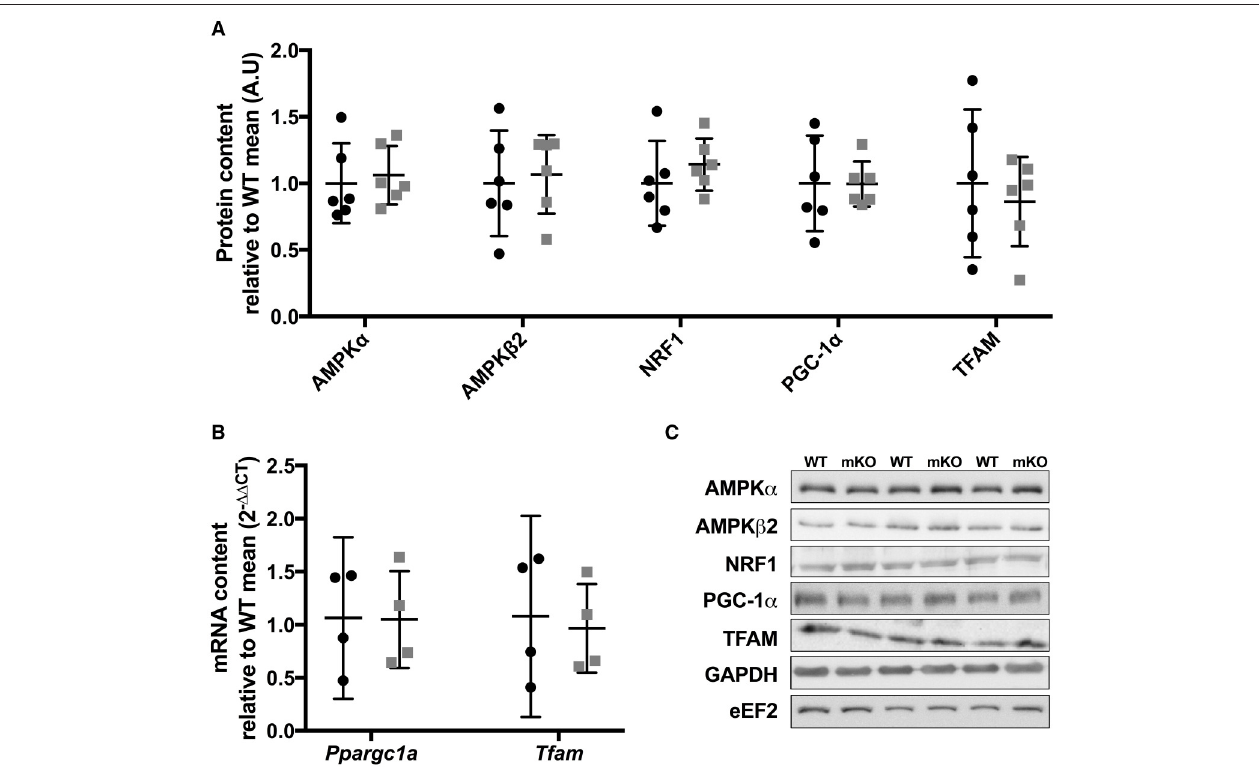
FIGURE 5 | Protein content of mitochondrial biogenic signalling and transcriptional proteins in p53 mKO (grey squares) and WT (black circles) mice. (A) The content of proteins regulating energy sensing (AMPK α , AMPK β 2), nuclear transcription (NRF1 and PGC-1 α ) and mitochondrial transcription (TFAM) are comparable in gastrocnemius muscle of WT (black circles) and p53 mKO (grey squares) mice ( p > 0.05; n = 6 per group). Similar results were observed in triceps and quadriceps muscle (data not shown). (B) The mRNA expression of Pparg1a and Tfam are similar in quadriceps muscle of WT (black circles) and p53 mKO (grey squares) mice ( p > 0.05; n = 4 per group). (C) Representative immunoblot